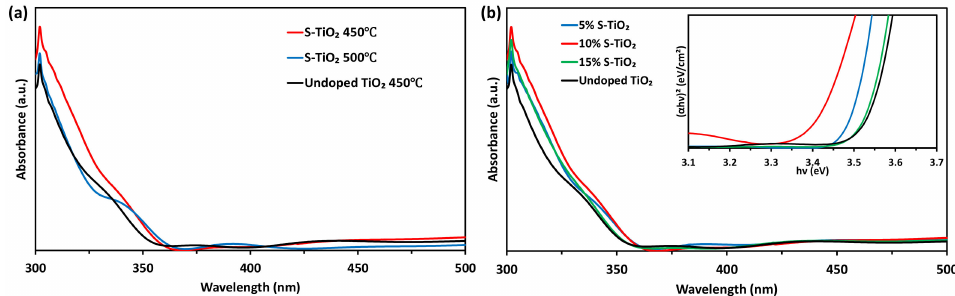
Figure 1. UV-Vis absorption spectra and Tauc plots (inset plot) of various TiO 2 photo-anodes ( a ) sintered at different temperatures and ( b ) with different loadings of S